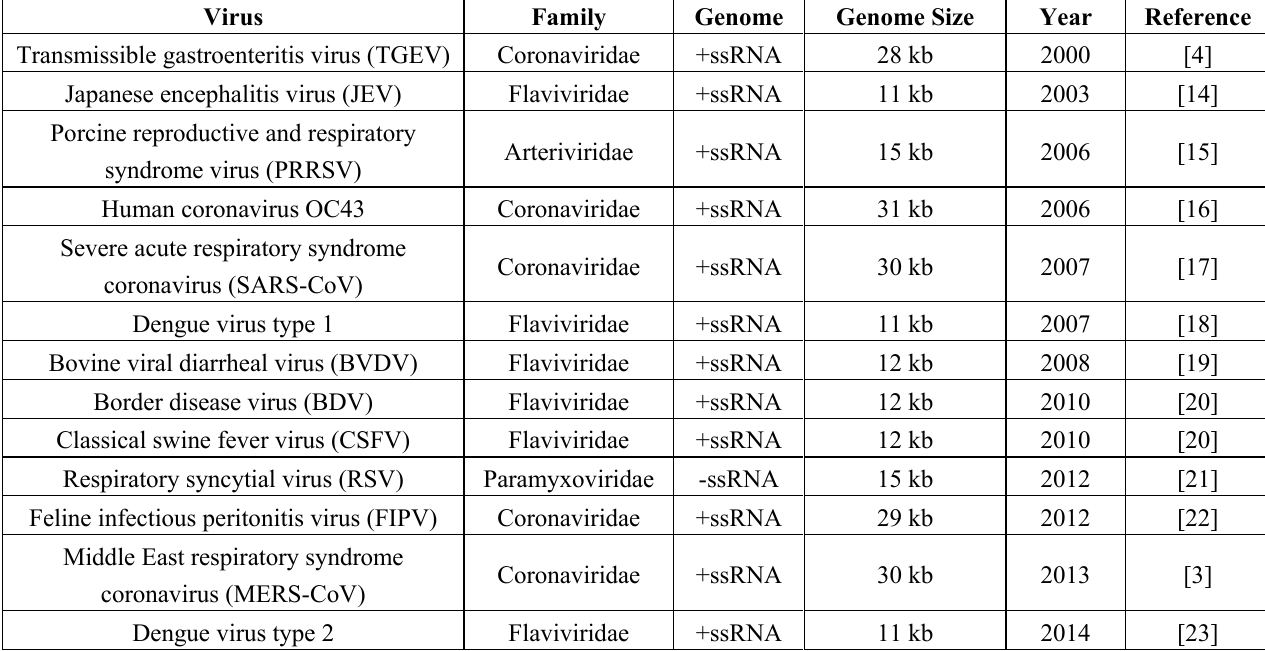
Table 1. BAC-based reverse genetics platforms for recovery of recombinant RNA